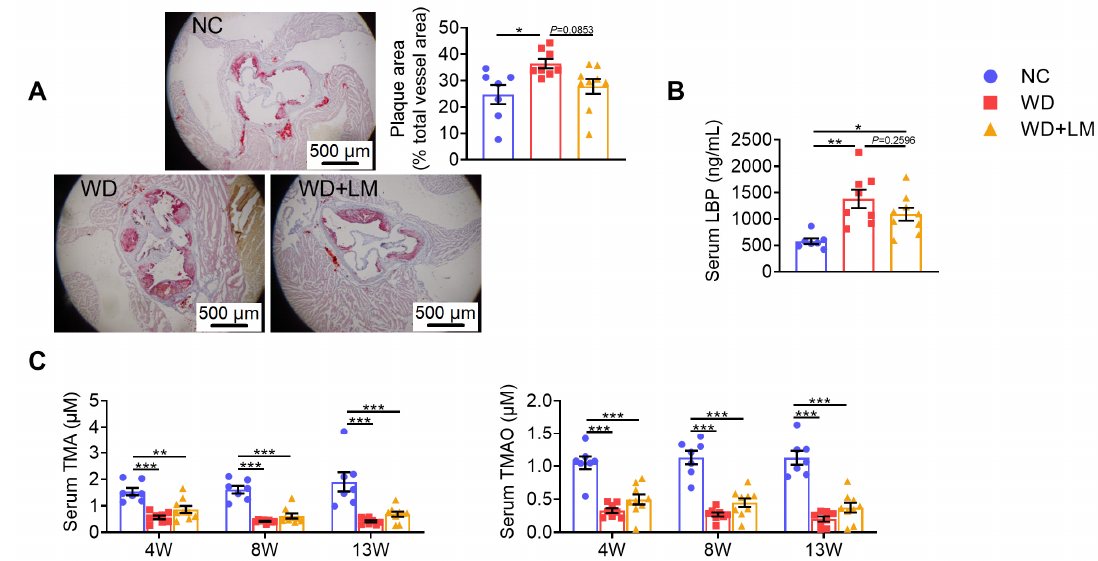
Figure 3. L. mucosae A1 protected Western diet-fed ApoE - / - mice from atherosclerosis. ( A ) Representative photomicrographs of Oil Red O-stained sections of aortic sinus under 40 × magnification and area ratio of atherosclerotic plaque. The scale bar is 500 µ m. ( B ) The level of lipopolysaccharide-binding protein (LBP) in serum. ( C ) The level of trimethylamine (TMA) and trimethylamine- N -oxide (TMAO) in serum collected at the 4th, 8th and 13th week. All the data are shown as means ± s.e.m. NC: n = 7, WD: n = 8, WD + LM: n = 9. Values of each group were analyzed by one-way analysis of variance (ANOVA) followed by Tukey’s post hoc test. * p < 0.05, ** p < 0.01, *** p <